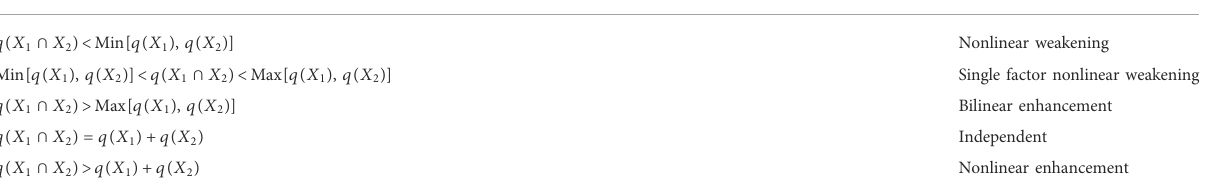
TABLE 3 Judgment basis of the interaction